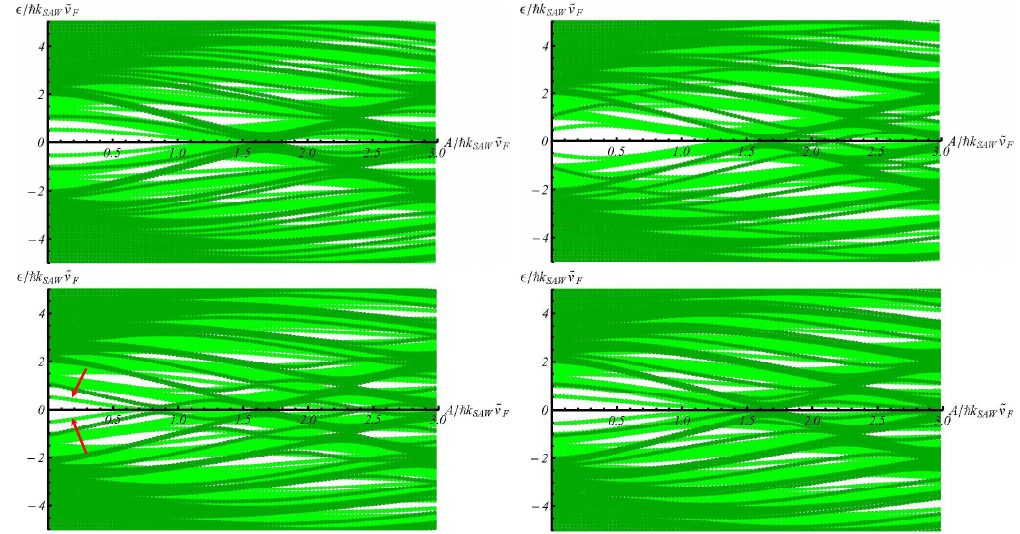
Figure 2. (Color online) Scaled electron energy spectrum ε ( k ) / ( (cid:126) ˜ v of electron traps as a function of the normalized SAW amplitude A/ ( (cid:126) ˜ v semiconducting nanoribbons subjected to an acoustically induced SAW potential. In this figure, we chose the energy gap ∆ / ( (cid:126) ˜ v V / ( (cid:126) ˜ v k ) = 1 . 0 for all four panels. As in Figure 1, only the eigen-spectra due trap F SAW to the two lowest dispersion curves in the absence of the SAW are shown. Here, the k / (2 π ) of electron traps, moving with the SAW potential, is located at: 1 / 3 position x 0 SAW (upper-left panel), 1 / 5 (lower-left panel), 1 / 7 (upper-right panel), and 1 / 11 (lower-right panel). Two induced trap-state energy levels within the energy gap are indicated by arrows in the lower-left panel for